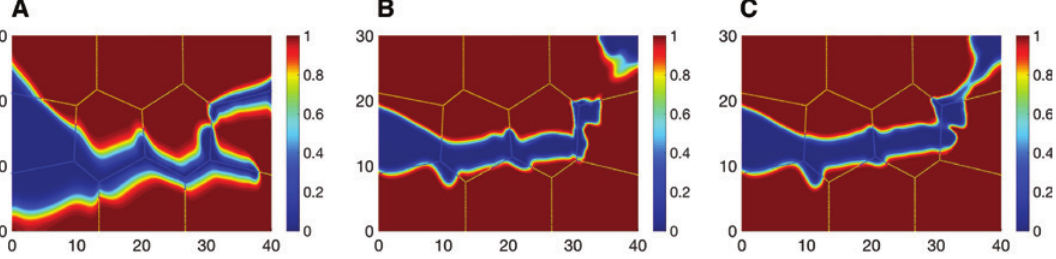
Figure 6: Comparison of crack path for different cases: (A) case study (C1) with the low mechanical loading and